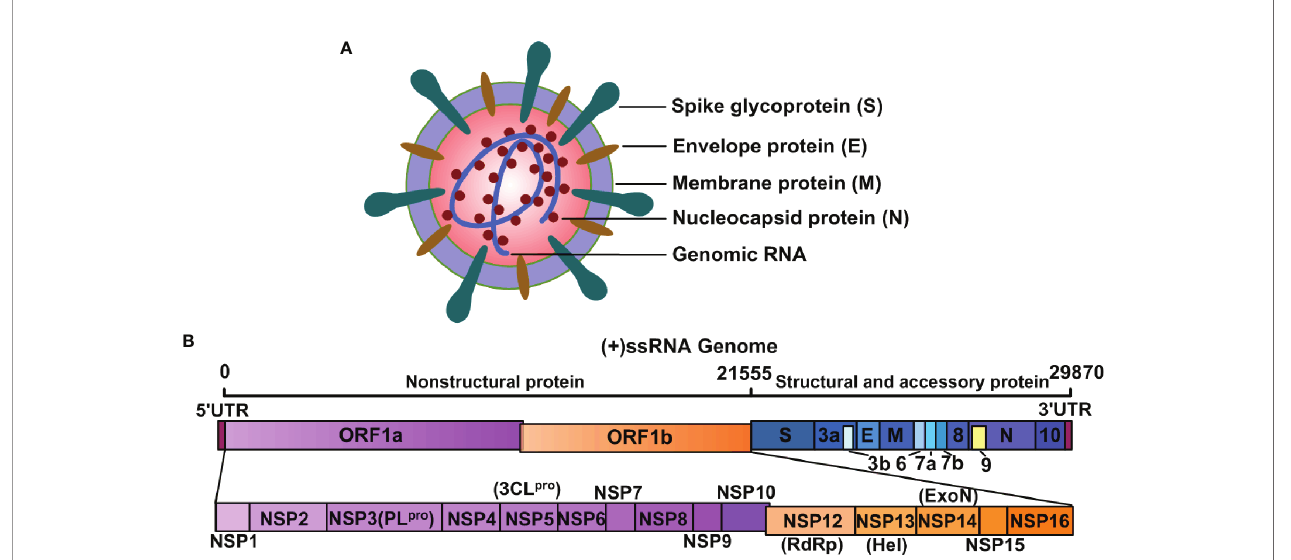
FIGURE 1 | Structure of SARS-CoV-2 and its genomic RNA. (A) SARS-CoV-2 is composed of spike glycoprotein (S), envelope protein (E), membrane protein (M), nucleocapsid protein (N), and genomic RNA. These components guide the transcription and translation of its nonstructural, structural, and accessory proteins. (B) SARS- CoV-2 is a single-stranded ribonucleic acid (+ssRNA) virus and the genome components encode both structural and nonstructural components of